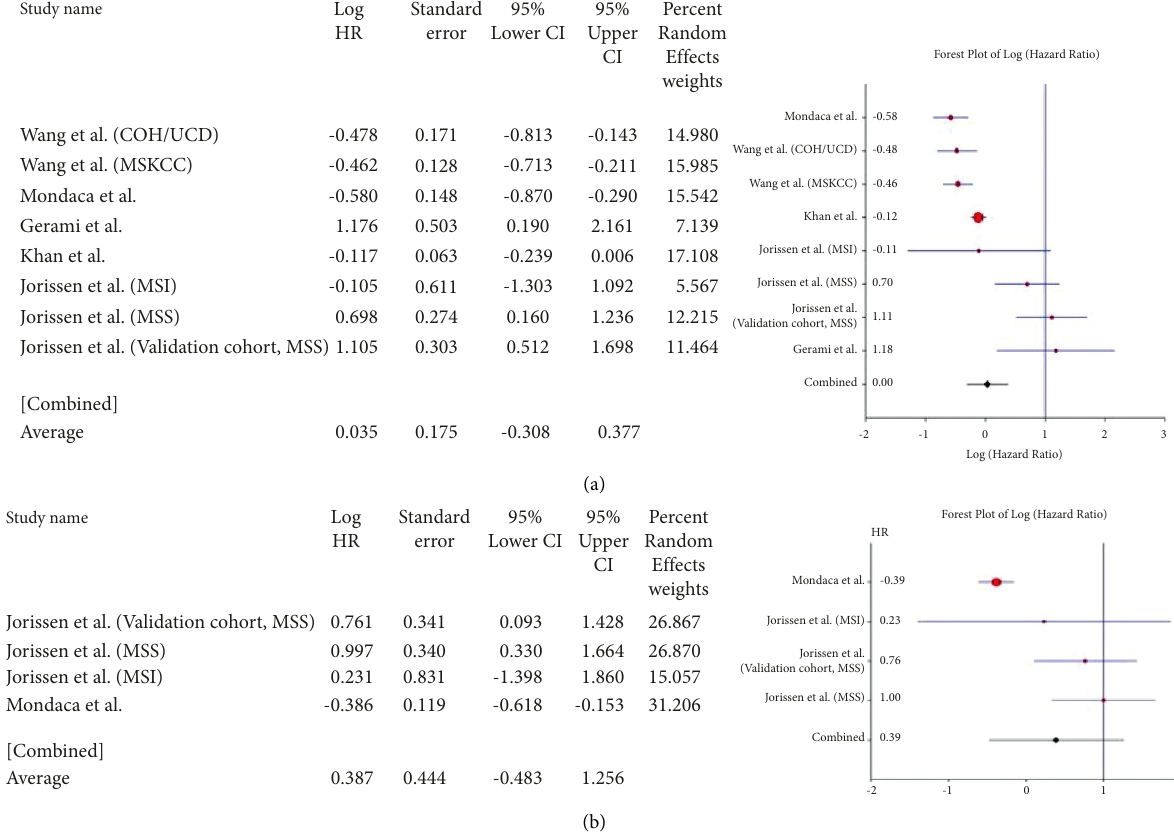
Figure 3: Forest plot of APC gene and overall survival in CRC (a). Forest plot of APC gene and disease-free survival in CRC